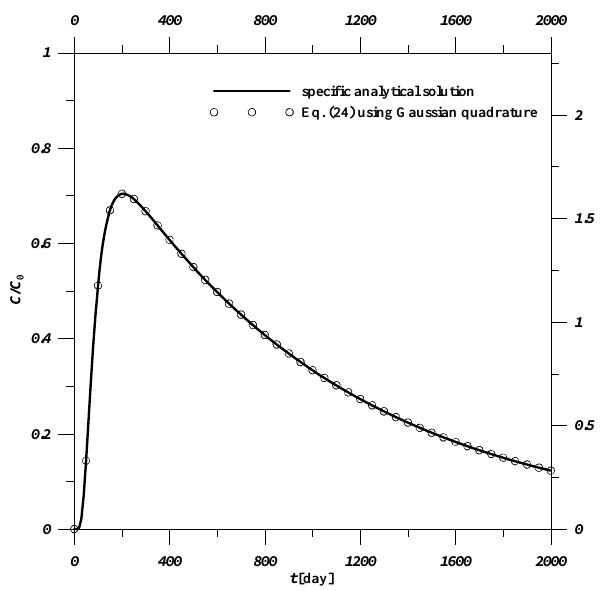
Fig. 5. Comparison of the breakthrough curves at x = 100m from Fig. 5 the numerical integration of Eq. (24) and the specific analytical so- lution for exponentially decaying input function ( f (t) = exp ( − t))